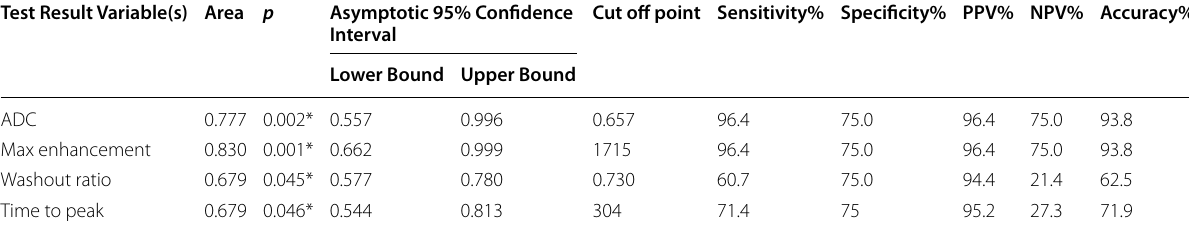
*means that the P value is significant